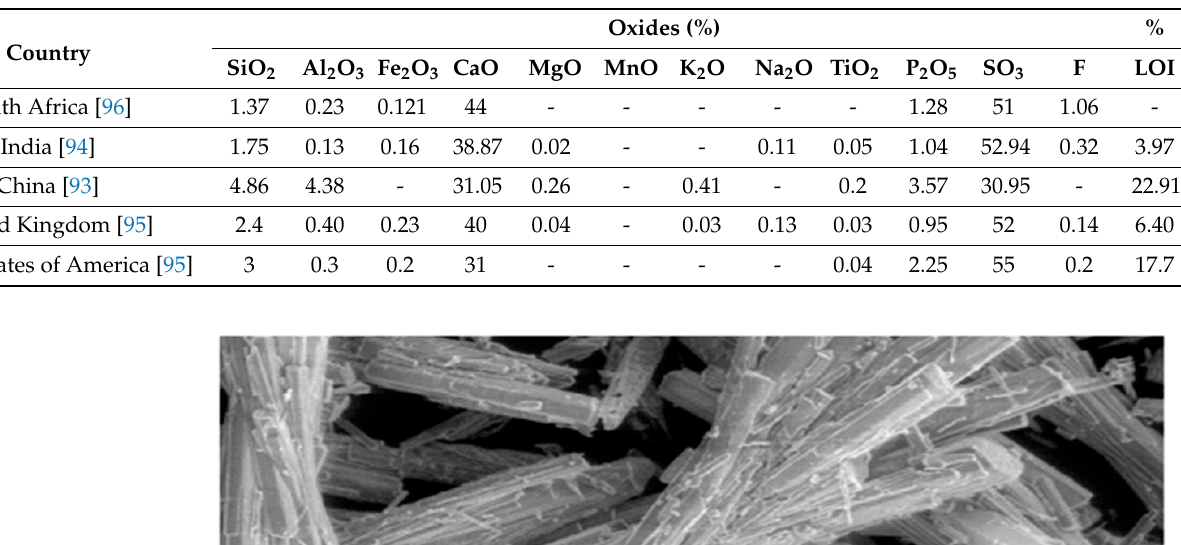
Table 3. Chemical composition of phosphogypsum in different areas of the world.